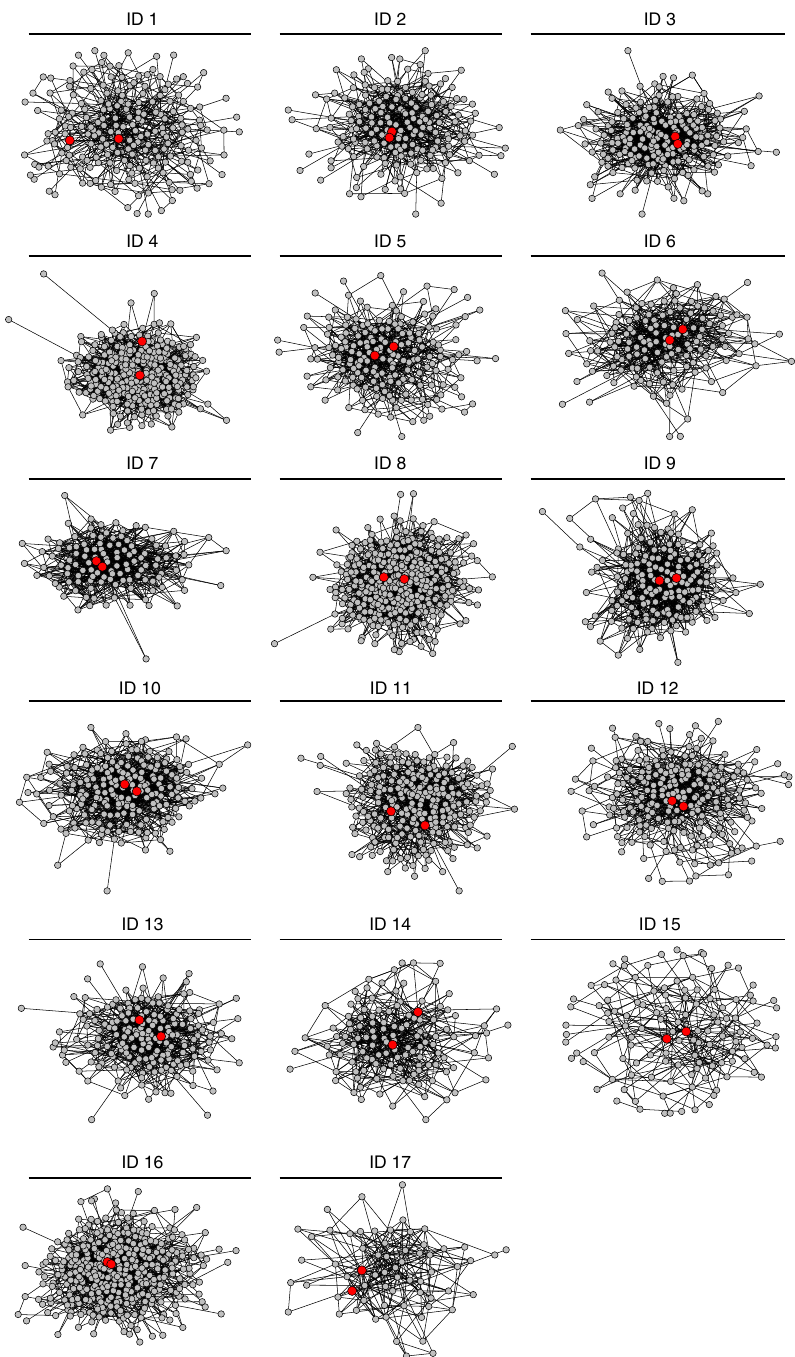
Fig. 1 Community medicine distributors in full village friendship networks. Figure 1 presents friendship networks for each of the 17 study villages. The numbers above each graph are the village IDs. The red nodes represent the location of the community medicine distributors (CMDs) in the network. In all villages, CMDs are well connected and embedded in the center of their village friendship network. Full descriptions, including the number of nodes and edges, are provided in Supplementary Table